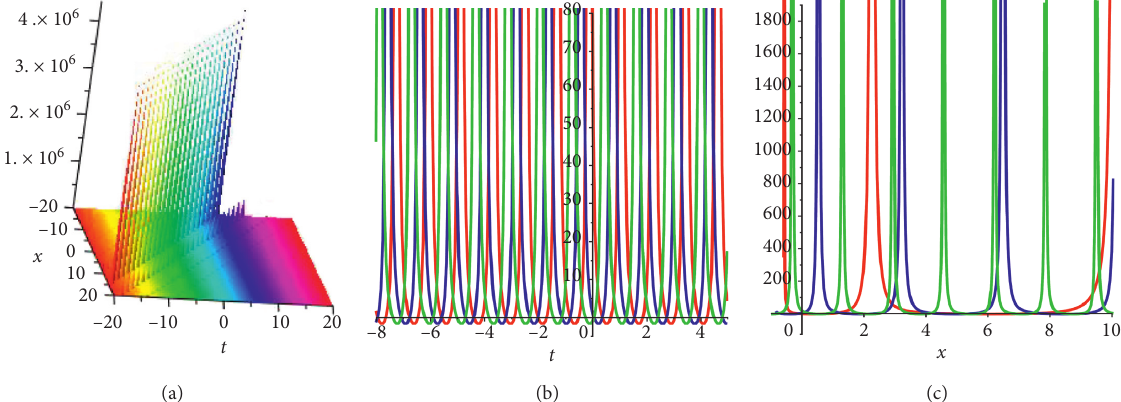
Figure 1: The plot of (26) Ψ plot (red α � 0 . 5, blue α � 0 . 75, and green α � 0 . 99).